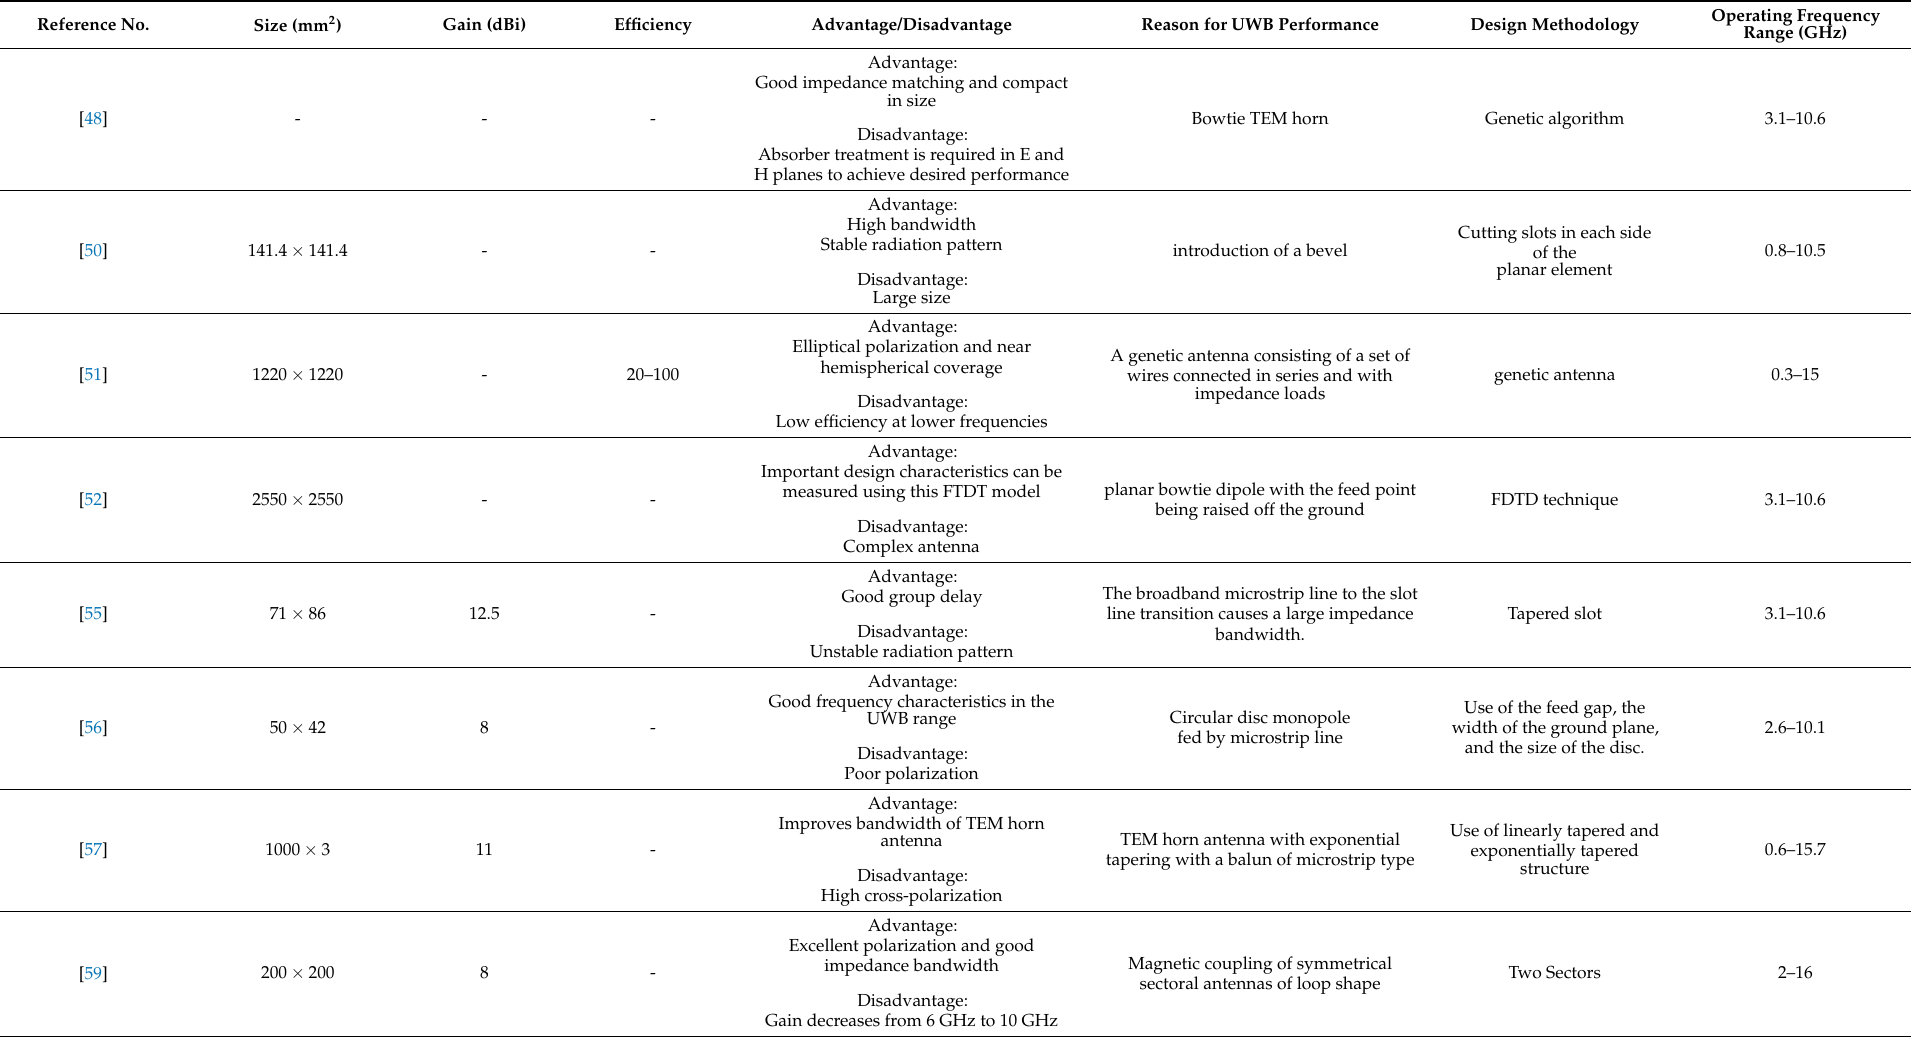
Table 2. The emergence of design of UWB